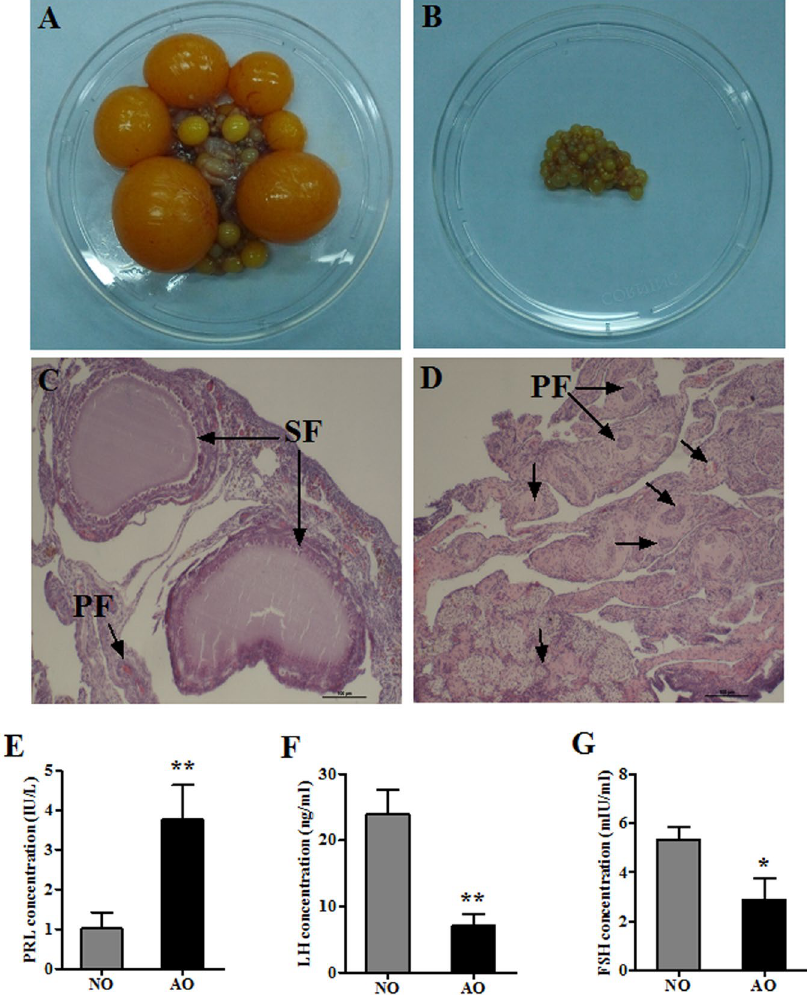
Figure 1. Ovarian morphological and histological characteristics and plasma hormones in egg-laying and broody chickens. ( A ) Morphological characteristics in the normal ovary (NO) of egg-laying hens (EH) and ( B ) the atrophic ovary (AO) of broody chickens (BC). ( C ) Histological characteristics in NO and ( D ) AO (HE staining at 100 × ); SF represents secondary follicles and PF is the primary follicles. ( E – G ) Plasma concentrations of prolactin (PRL), luteinizing hormone (LH) and follicle stimulating hormone (FSH) in EH and BC; results are expressed as means ± standard deviation (n = 6); * P < 0.05; ** P <